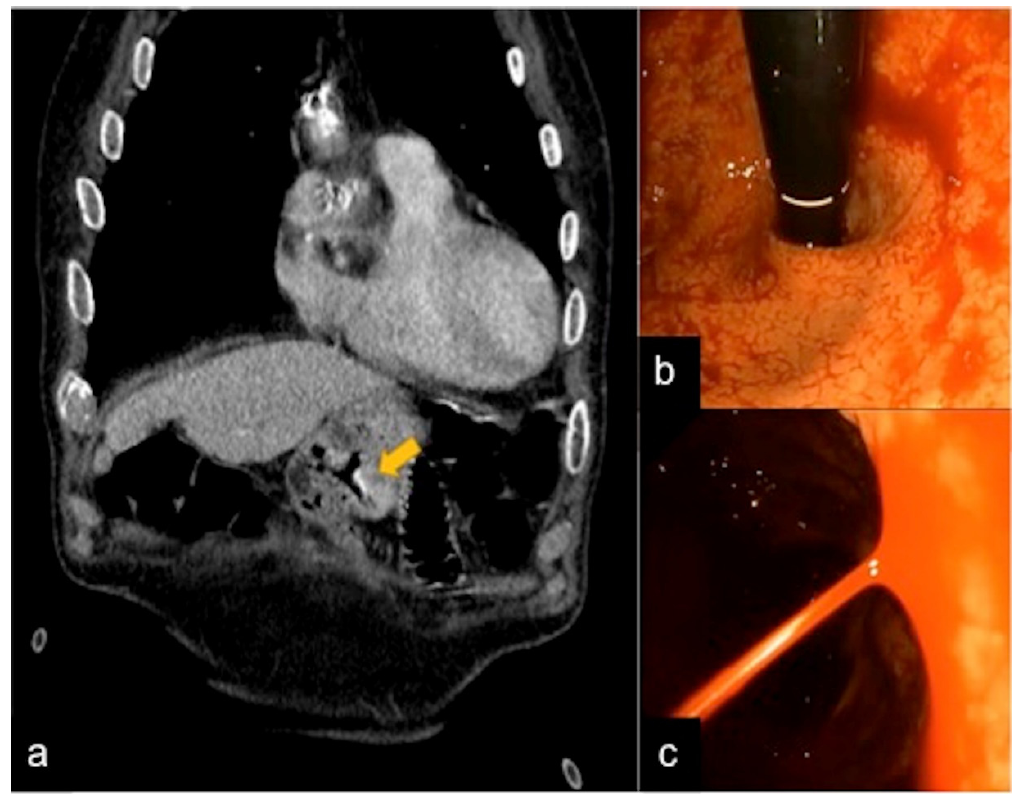
Figure 27. CTA multiphasic study of a gastric Dieulafoy lesion. In the arterial phase ( a ) and relative endoscopic evaluation ( b , c ), a vascular sub-mucosal lesion is identified ( a ,